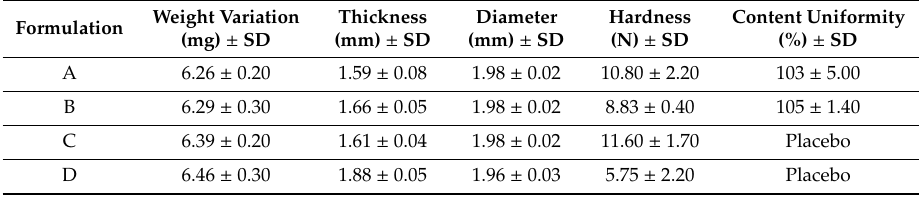
Table 2. Physical characterisation results for the di ff erent formulations.